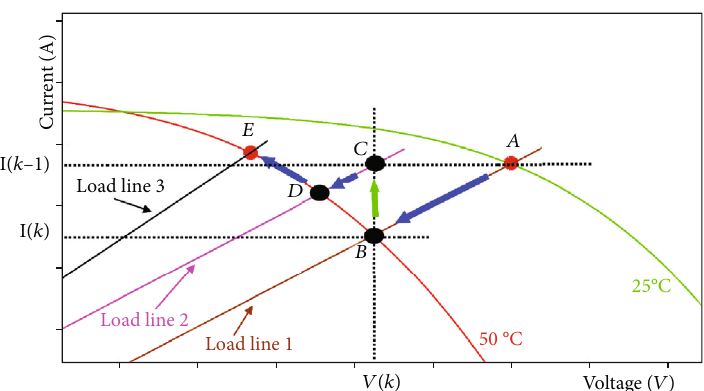
Figure 12: Operating point (OP) movement procedure under sudden increase of temperature.